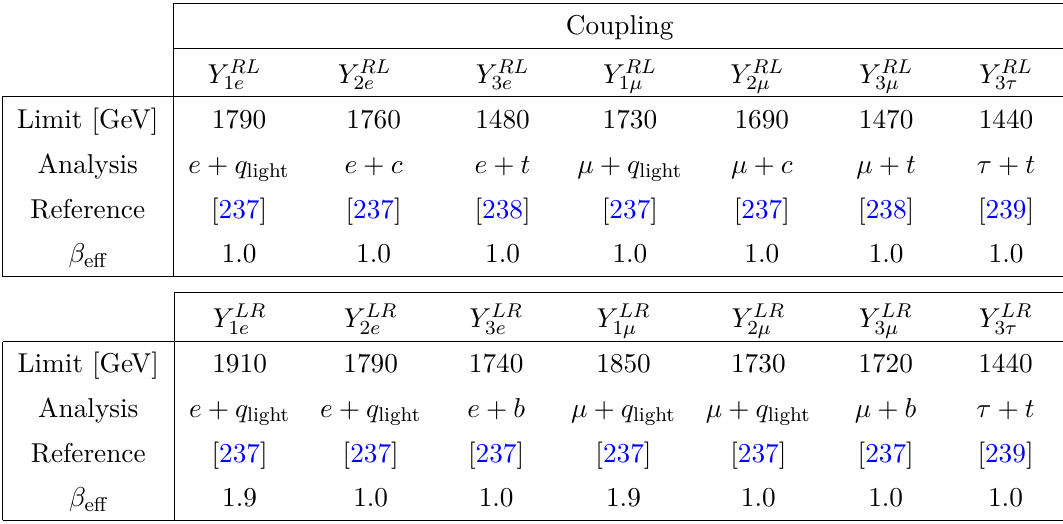
Table 1. 95% C.L. limits on the LQ masses M ‘ derived from the ATLAS pair production analyses targeting the processes pp → Φ Φ . Only the couplings indicated in the table header are 2 ,‘ 2 ,‘ → ‘q‘q assumed to be non-zero. We state the ATLAS analysis that yields the most stringent limits for the respective scenario, and additionally indicate the corresponding β value. The light quarks q eff light consist of u, d and s quarks. No analysis exists for leptoquark states coupling to τ and one of the u , d , c or s